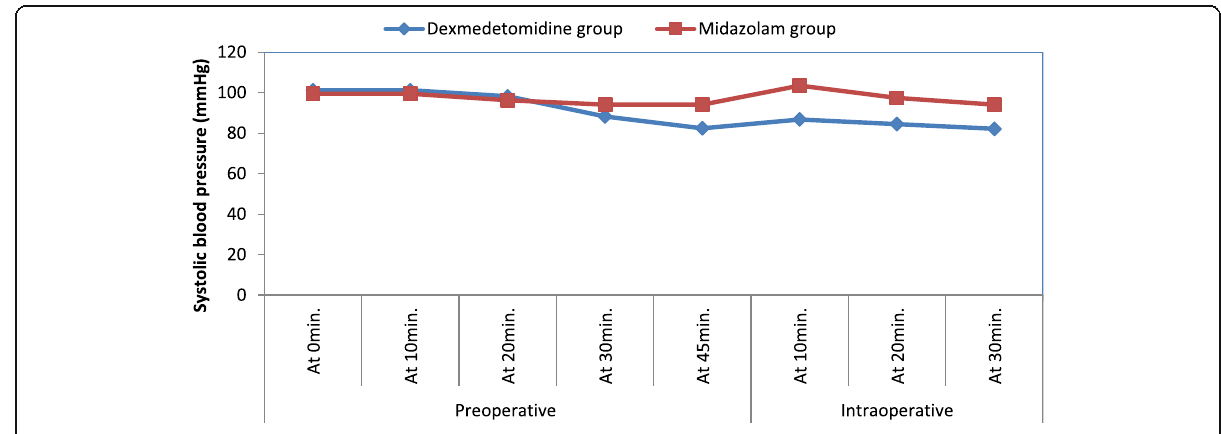
Fig. 2 Comparison between group D and group M regarding systolic blood pressure. Data are presented as mean